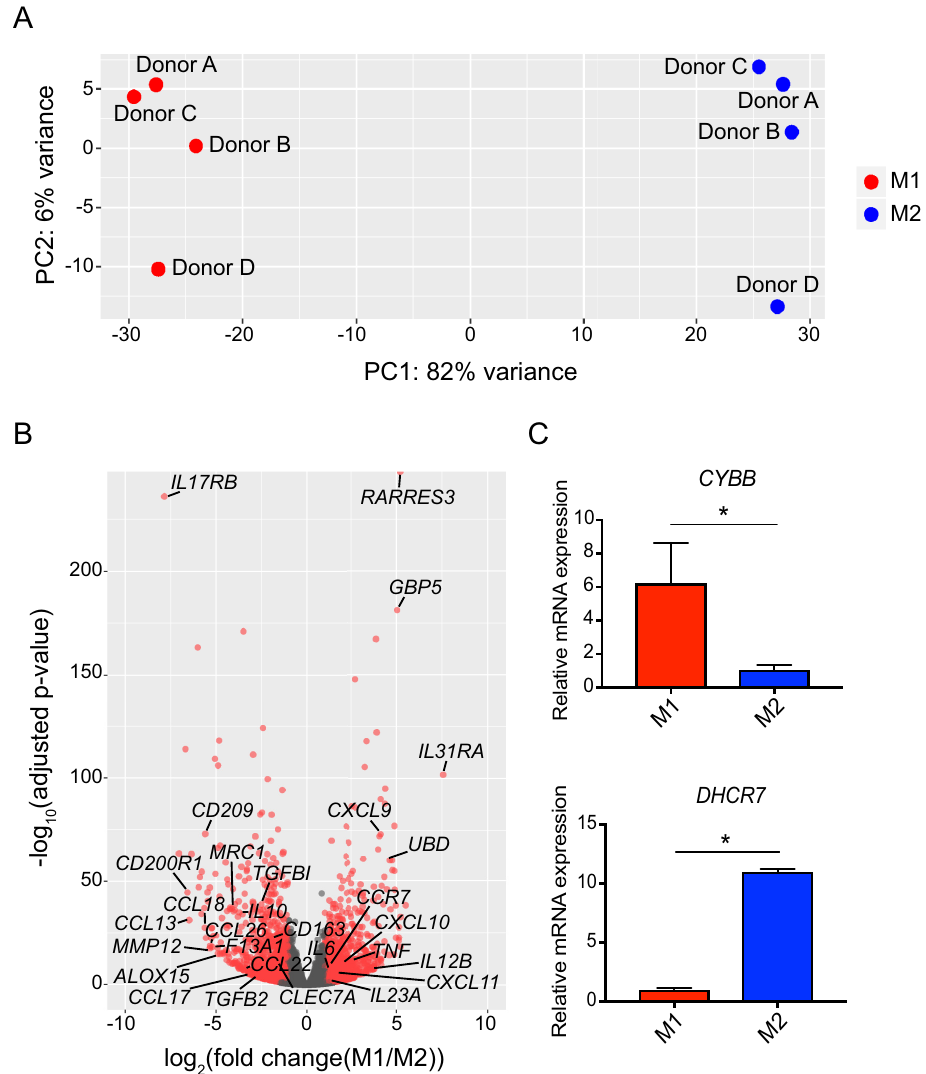
Fig 4. Transcriptional profiling reveals transcriptional regulation of macrophage polarization and novel markers of M1 and M2 macrophages. (A) PCA plot of all genes interrogated by RNA-Seq. Red and blue data points represent M1 and M2 macrophages, respectively. (B) Volcano plot. Red data points represent significantly differentially expressed genes (adjusted p-value < 0.05 and |log 2 FC(M1/M2)| > 1.0). Canonical M1 and M2 genes are labeled. (C) RT-qPCR validation of CYBB and DHCR7 gene expression in M1 and M2 macrophages. � p < 0.05 and error bars represent SEM of 3 biological